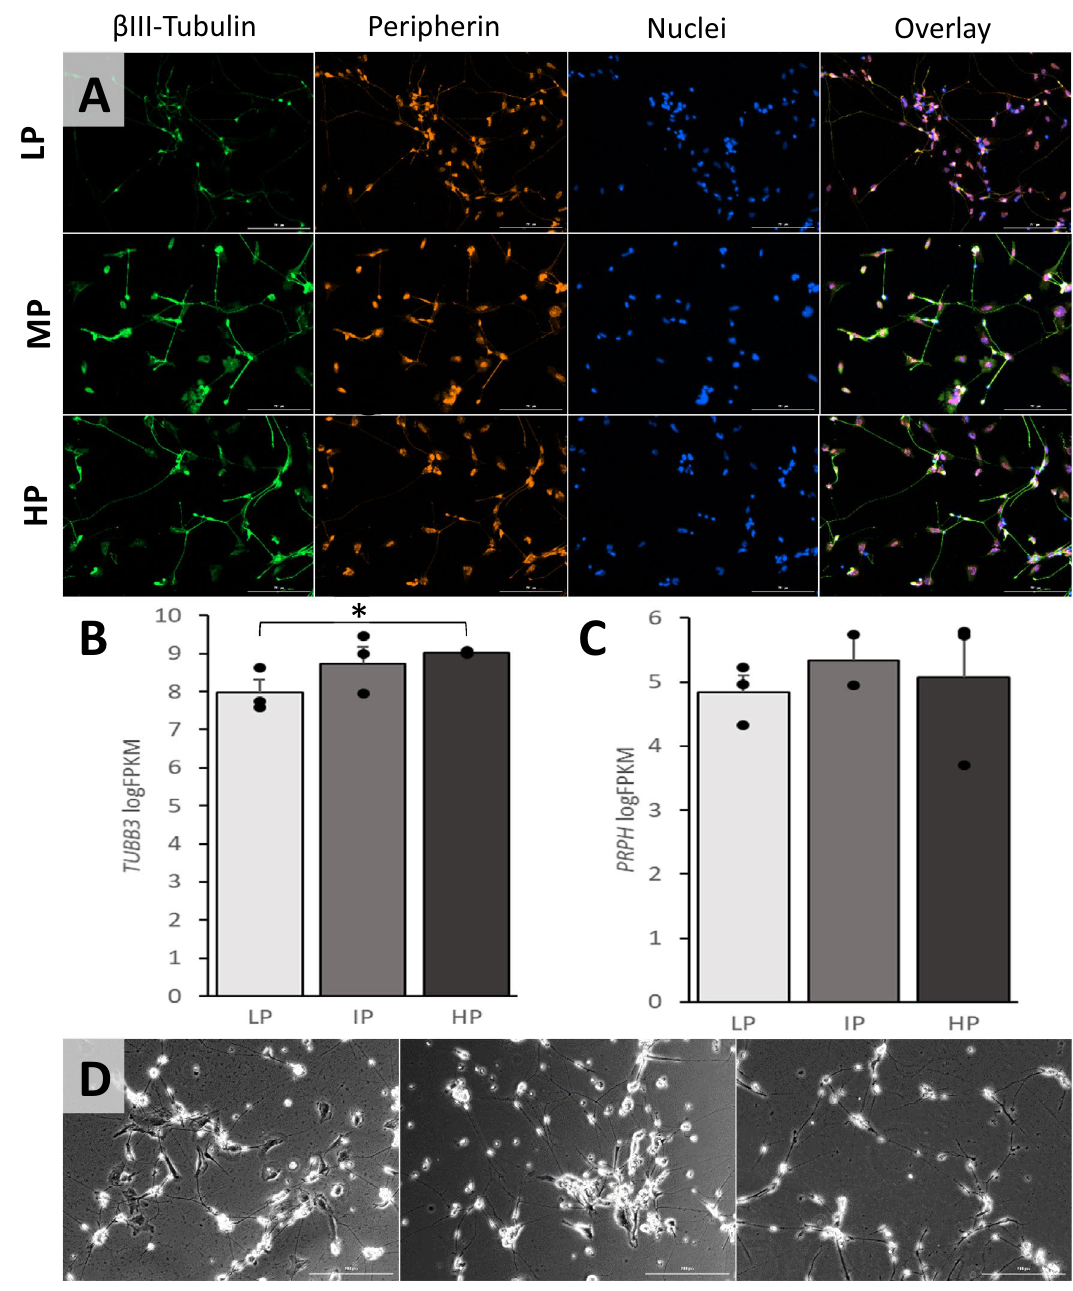
Figure 2. The morphology and expression of neuronal markers peripherin and βIII-tubulin in iPSC- dSNs differentiated from iPSCs at each of low, intermediate, and high passage numbers. ( A ) Representative immunofluorescent images of neurons stained for neuronal markers peripherin and βIII-tubulin. Scale bar = 200 microns. ( B ) Average expression levels of TUBB3 in iPSC-dSNs derived from iPSCs with different passage numbers by RNA-seq. ( C ) Average expression levels of PRPH in iPSC-dSNs derived from iPSCs with different passage numbers by RNA-seq. ( D ) Representative phase-contrast images of iPSC-dSNs derived from iPSCs